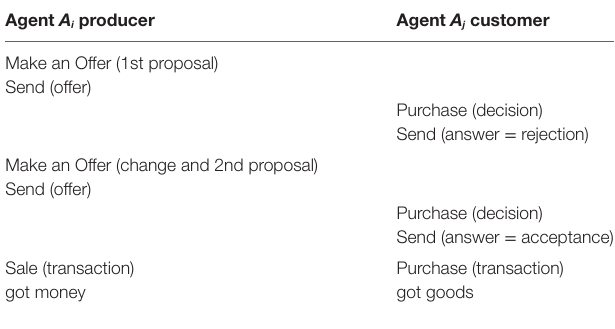
TaBle 1 | example of a protocol for a 2-step